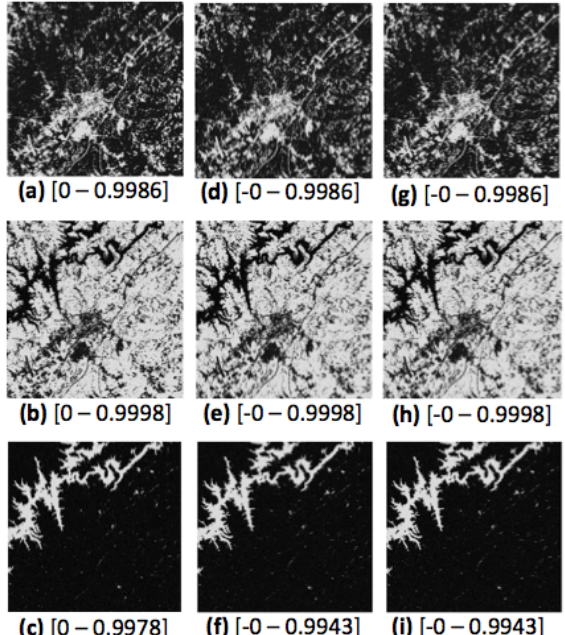
Figure 3. Abundance maps: (a - c) synthetic abundance for endmember 1-2-3; (d – f) abundance maps from SUnSAL, and (g – i) abundance maps from CSUnSAL from noise free data. In the figure, black indicates absence of a particular class (the minimum abundance value) and white indicates full presence of that class in a pixel (the maximum abundance value). Intermediate values of the shades of gray represent mixture of more than one class in a